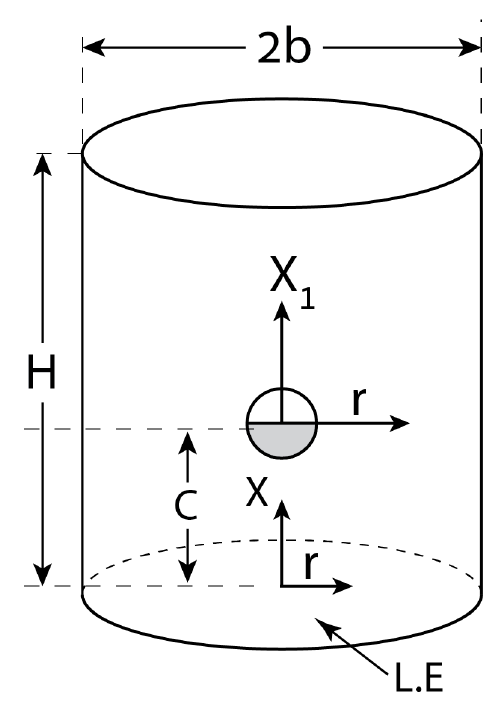
Figure 3. Freely suspended spherical colloid (NP/JP) placed at a distance c above a powered circular electrode along the axis of a cylindrical pore ( r = 0) of radius b and height H .